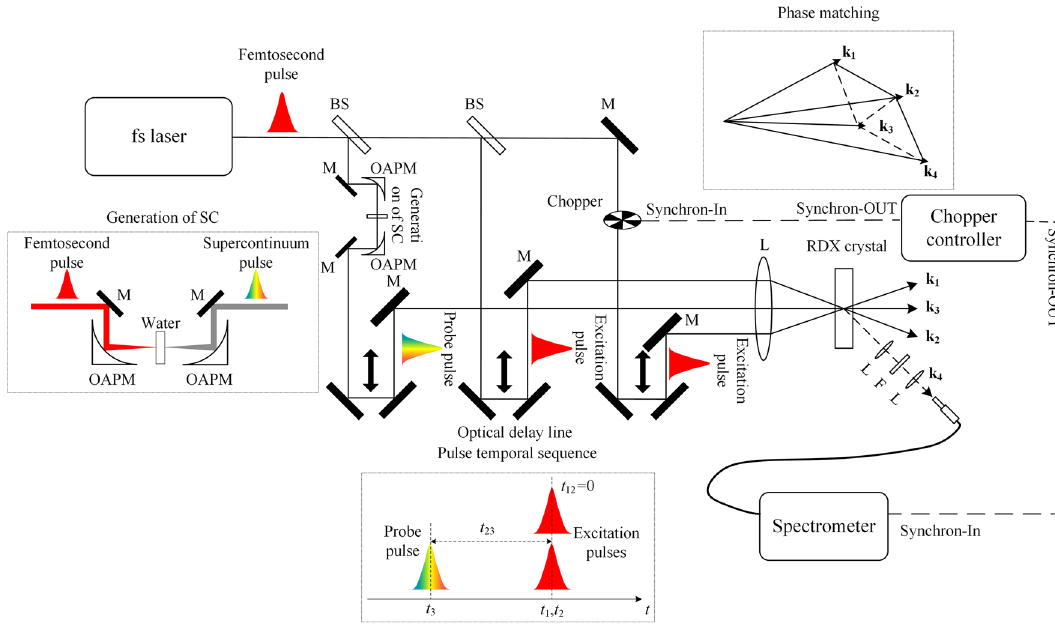
Figure 1. Schematic diagram of the experimental setup. BS beam splitter, M mirror, OAPM off-axis parabolic mirror, L lens, F